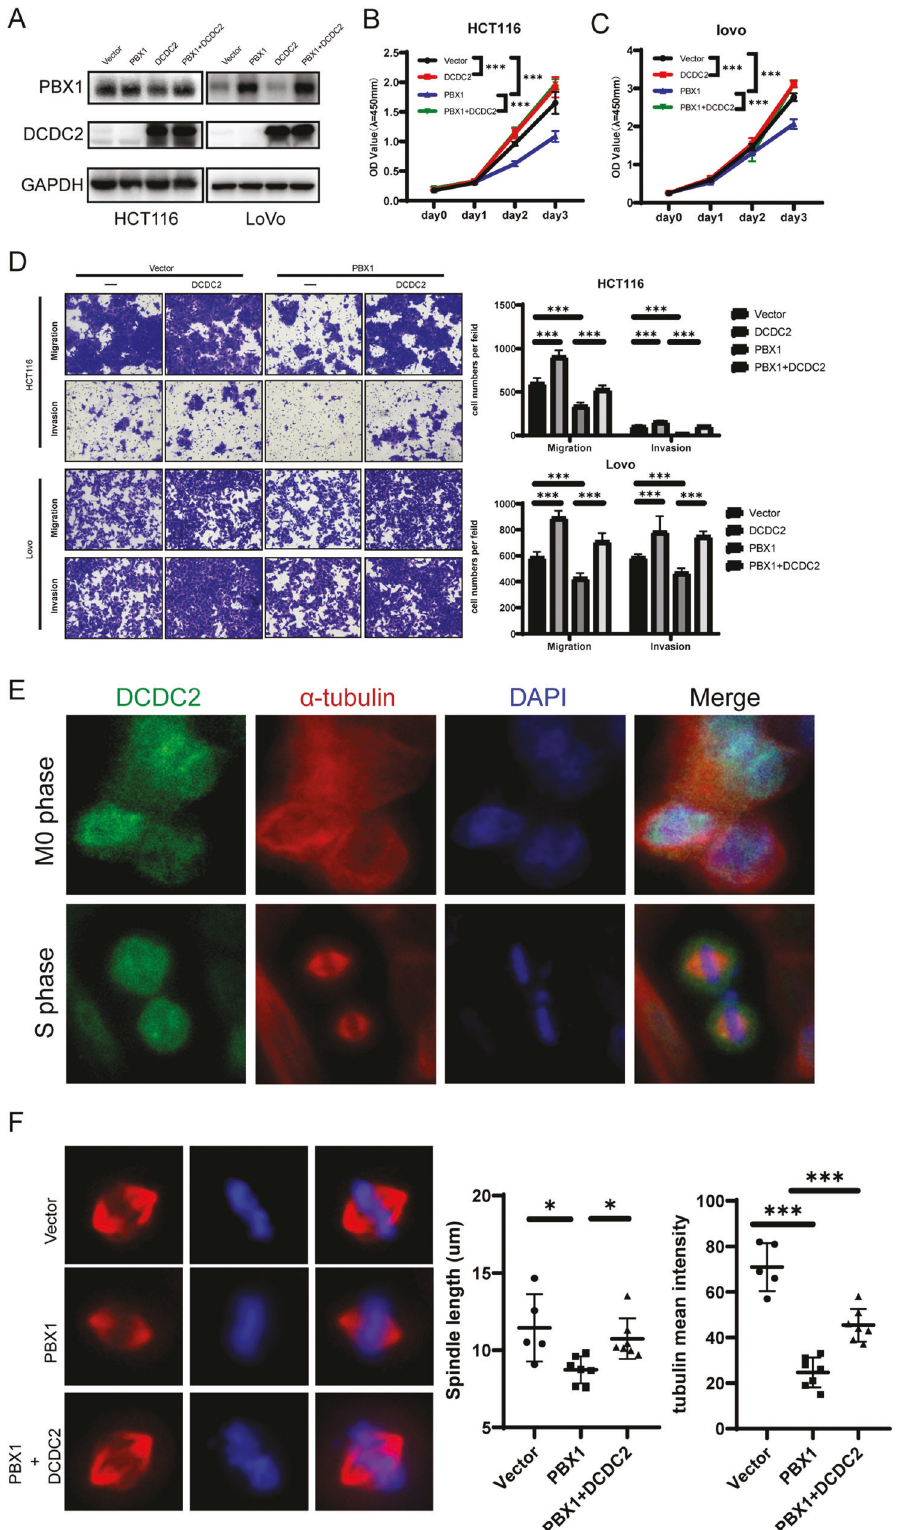
Fig. 6 DCDC2 rescued the proliferation and reversed metastasis inhibition under PBX1 overexpression. A DCDC2 plasmid was transfected in PBX1 overexpression CRC cells. PBX1 and DCDC2 protein levels were detected by western blotting assay. B – D The inhibited proliferation, migration, and invasion abilities by PBX1 were rescued upon DCDC2 overexpression as re fl ected by CCK-8 and transwell assay. E Immuno fl uorescence image of PBX1 and α -tubulin distribution in M0 and S phase of HCT116 cells. F The spindle length and tubulin intensity was rescued upon DCDC2